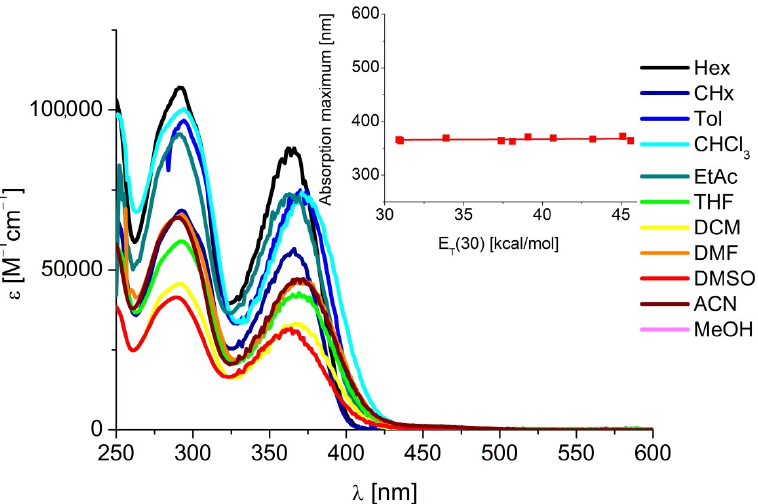
Figure 2. Comparison of the steady-state absorption spectra of tBuTPAterpy in solvents of different polarity (c = 10 μ M). Inset: dependence of the lowest absorption band maximum (nm) on the Dimroth-Reichardt polarity parameter E T (30) (kcal·mol − 1 ) [67]; Hex— n -hexane, CHx—cyclohexane, Tol—toluene, CHCl 3 —chloroform, EtAc—ethyl acetate, THF—tetrahydrofuran, DCM—dichloromethane, DMF—dimethylformamide, DMSO—dimethylsulfoxide, ACN—acetonitrile, MeOH—methanol.